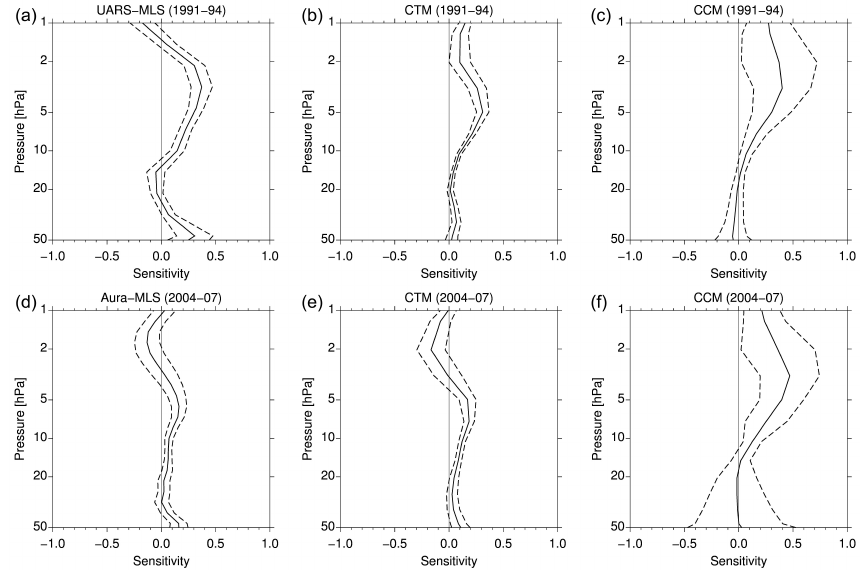
Figure 7. Vertical profile of ozone sensitivity to F205 (% change in ozone for 1% change in F205) at lag 0 for the (a, b, c) 1991–1994 and (d, e, f) 2004–2007 periods. Results are shown for (a) UARS MLS, (d) Aura MLS, (b, e) CTM simulations and (c, f) CCM ensemble simulations. (a, b, d, e) The dashed envelope indicates the 2 σ standard error of the regression estimates. (c, f) The dashed envelope indicates the 2 σ ensemble simulation